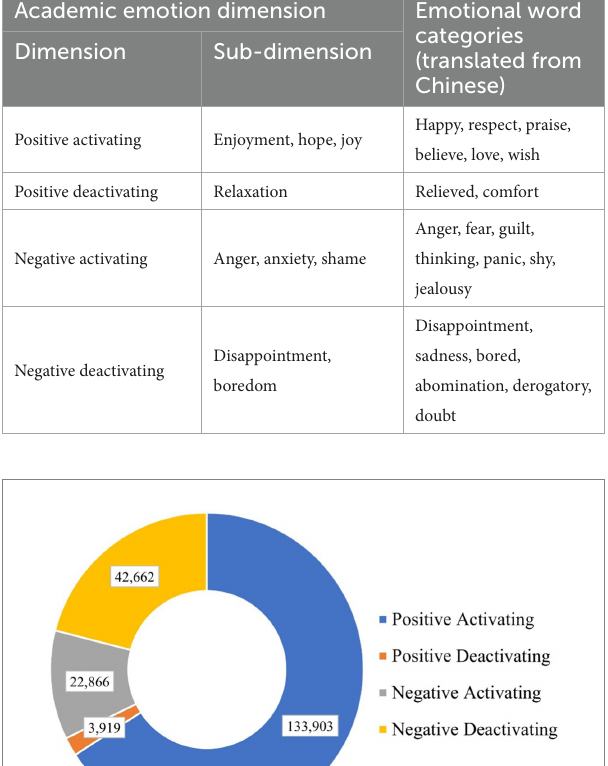
TABLE 1 Academic emotion dimensions. Academic emotion dimension